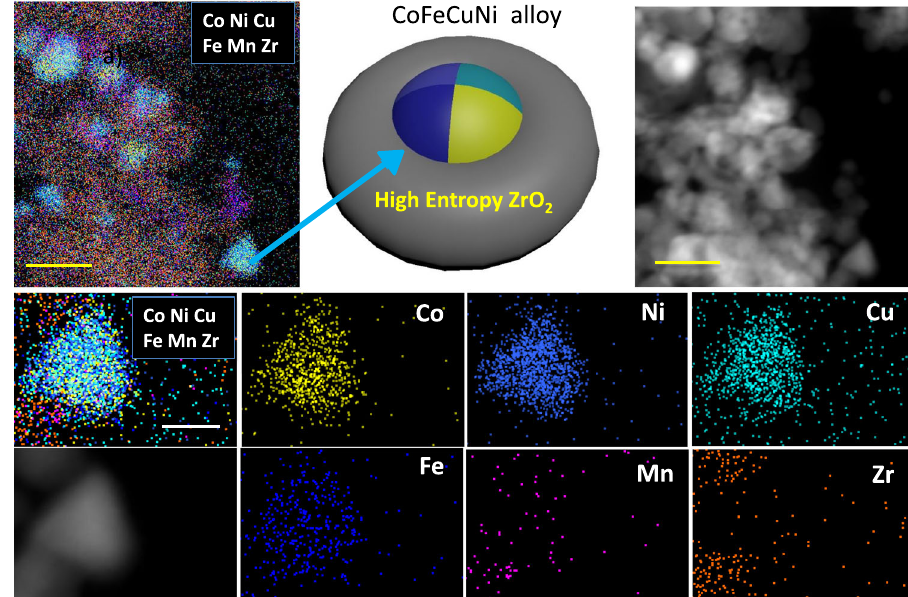
Fig. 6 The characterization of H 2 -reduced Zr 0.5 (NiFeCuMnCo) 0.5 O x . STEM-HAADF images and EDS elemental maps of Zr 0.5 (NiFeCuMnCo) 0.5 O x (treated at 400°C, H 2 ). Yellow scale bar, 30 nm. White scale bar, 10